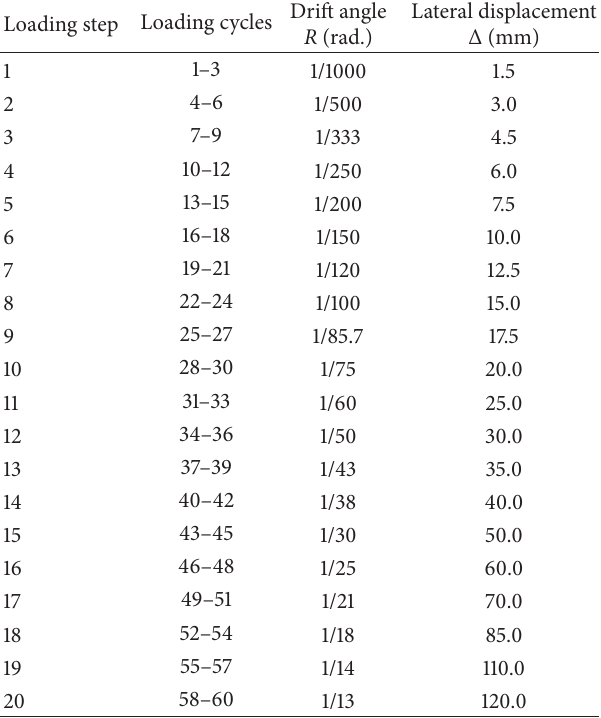
Table 7: The load cycles used during the cyclic loading tests. Loading step Loading cycles